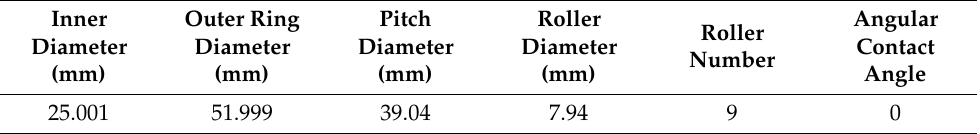
Table 1. Size parameters of